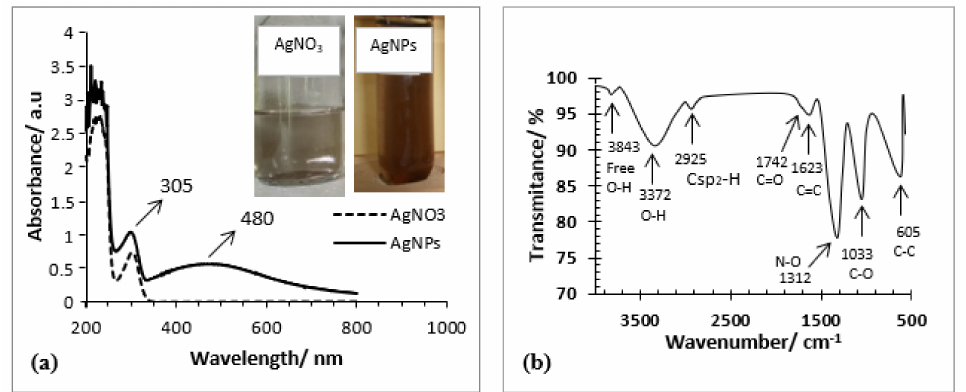
Figure 1. ( a ) UV-Vis spectra of silver nitrate (AgNO 3 ) solution and aqueous colloidal silver nanopar- ticles (AgNPs); ( b ) FTIR spectra of the synthesized